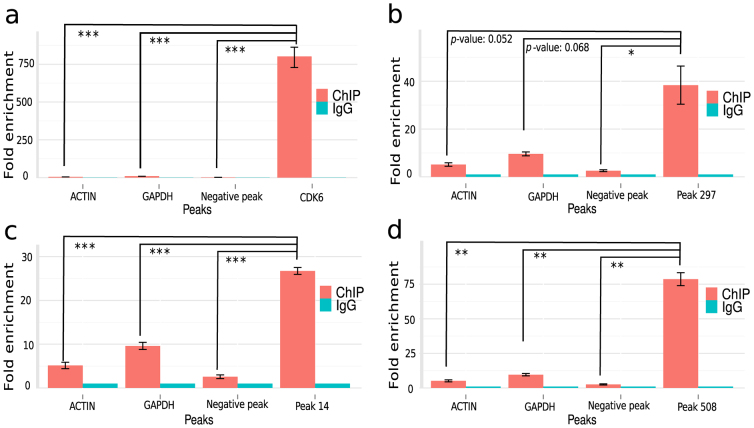
Validation of recovered TAL1 binding peaks by ChIP-qPCR.Each bar represents fold enrichment of peaks relative to IgG. Error bars represent standard error. Statistical significance is as a result of t-test between the validated peak enrichment and the negative controls of ACTIN, GAPDH, and negative peak; n = 3. Actual p-value is indicated when >0.05, otherwise p-value < 0.05 indicated by *; <0.01 by **; and <0.001 by ***. The CDK6 bar graph represents the results with a positive control; a known TAL1 direct target.